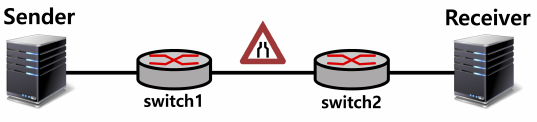
Figure 3. Physical testbed